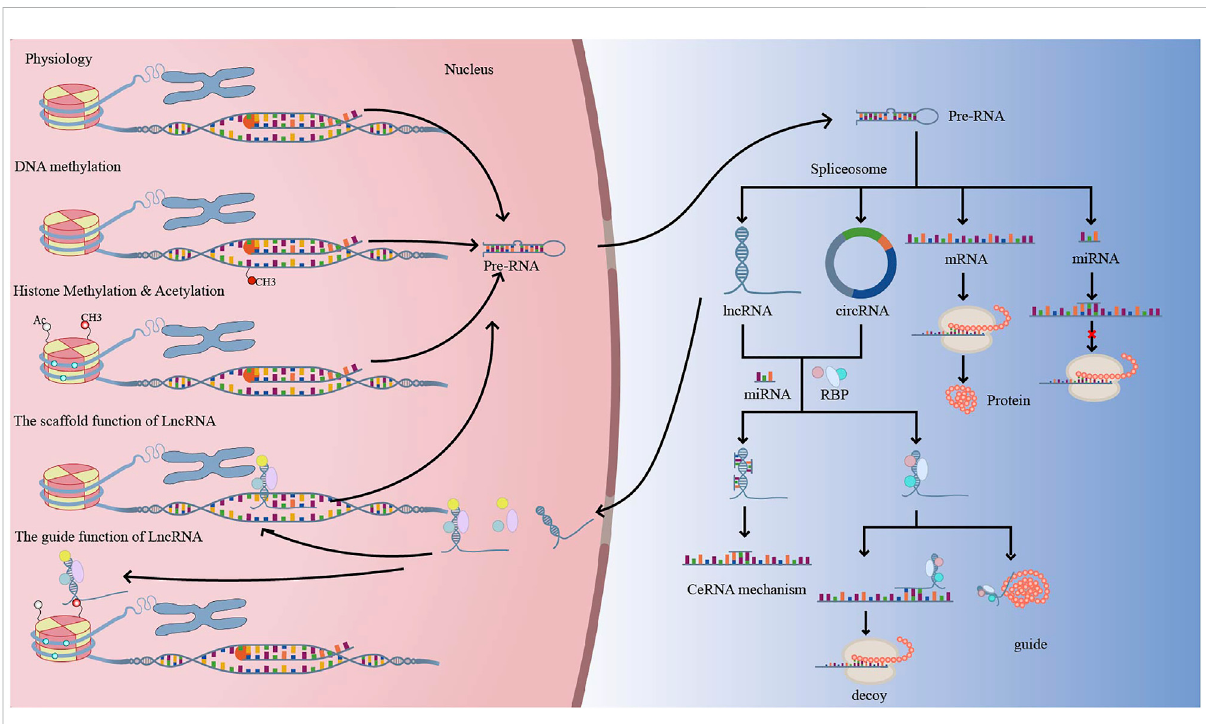
FIGURE 2 Underphysiologicalconditions,DNAistranslatedintoprecursorRNA(pre-RNA),whichexitsthenucleusandissplicedintoprotein-codingRNA (mRNA) and non-coding RNA (miRNA, LncRNA, CircRNA, etc.). Normally, when DNA is methylated, pre-RNA transcription decreases, which in turn regulates genes related to neovascularization. LncRNA or CircRNA have similar mechanisms of action, with LncRNA acting as signal, decoy, guide, and scaffold to regulate gene transcription, translation, and post-translational modi fi cations. Methylation and acetylation of histones can alter chromatin accessibility and facilitate transcriptional complexes into promoter regions, regulating gene